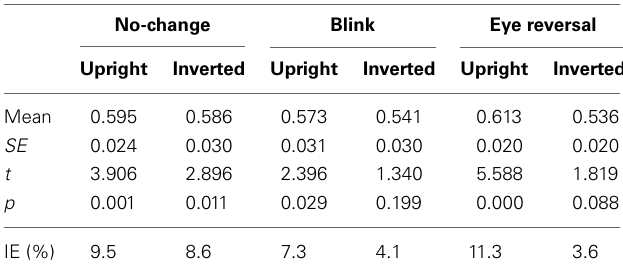
Table 6 | Predominance ratio statistics for rivalry of faces versus houses ( N =